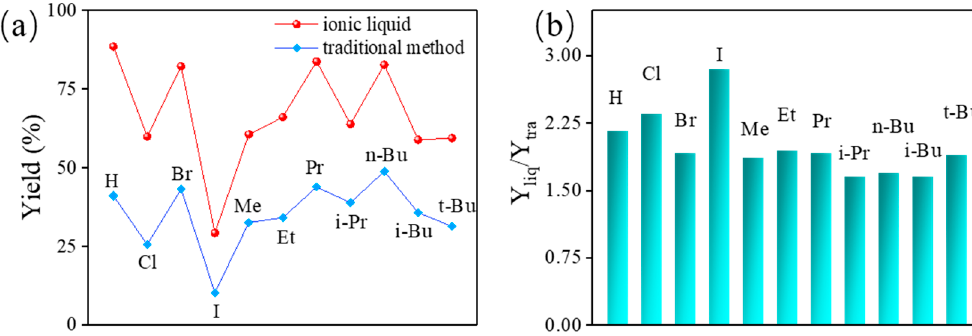
Figure 2. ( a ) The production yield of 3a-3k synthesized in ionic liquids (red) for 48 h, and in traditional solvent (blue) for 168 h, and ( b ) the corresponding yield ratio values (Yliq, Ytra donated to the yield gained in ionic liquids and traditional solvent, respectively).